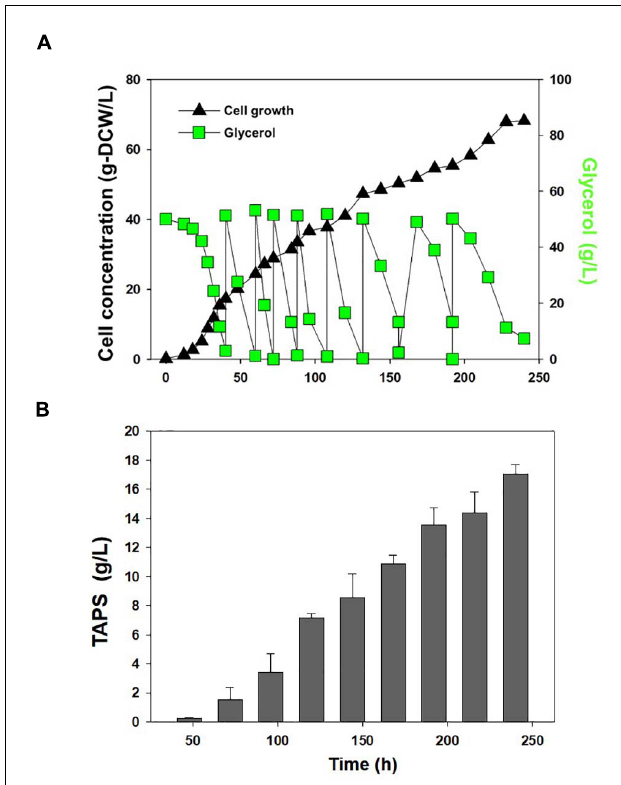
FIGURE 6 | Fed-batch fermentation of mutant 736. (A) Cell growth and glycerol consumption kinetics of mutant 736 during fed-batch culture. A triangle represents cell concentration; a square, glycerol. (B) TAPS concentration during fed-batch culture.